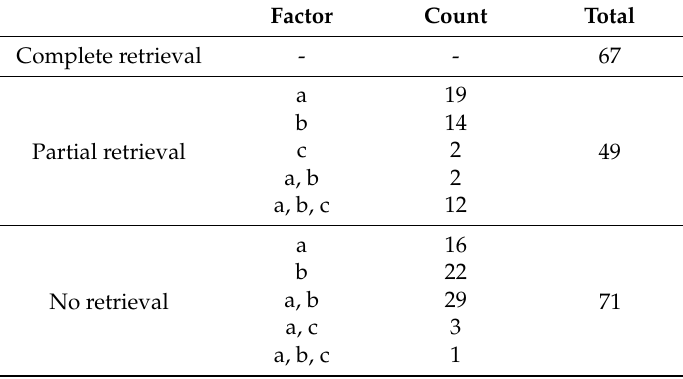
Figure 8. TOA NDVI simulation results for six types of land cover. The satellite zenith angle was 30°, the solar zenith angle was 30°, and the relative azimuth angle was 120°. In this simulation, the aerosol type was assumed to be continental, and the AOD ranged from 0 to 3.